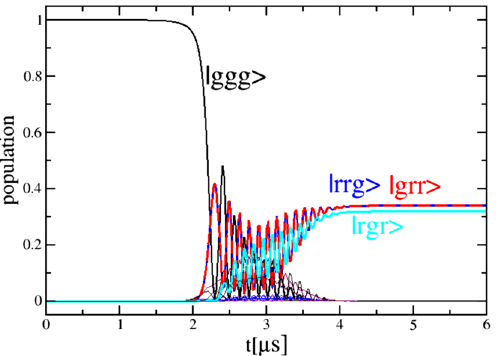
grr rrg rgr , and states leading to the formation of | � | � | � 1 µ s, (cid:31) 1.4 GHz, δ = = − 2 V 31 V 32 V = 60 = = =